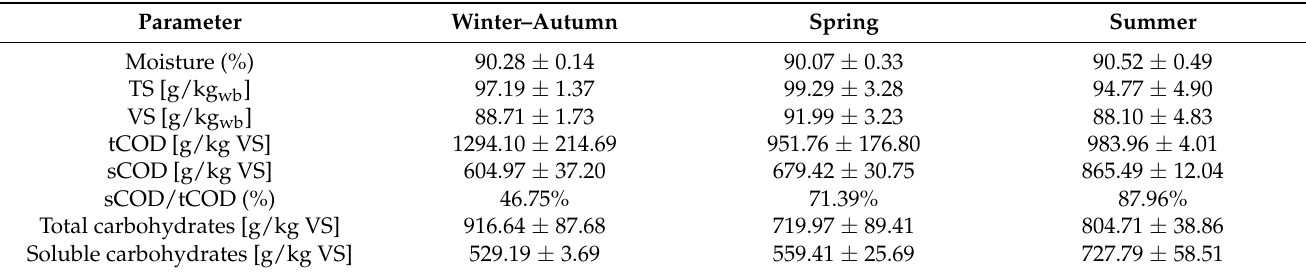
Table 3. Physical–chemical characteristics of the winter-autumn, spring and summer fruit and vegetable waste compositions used in this